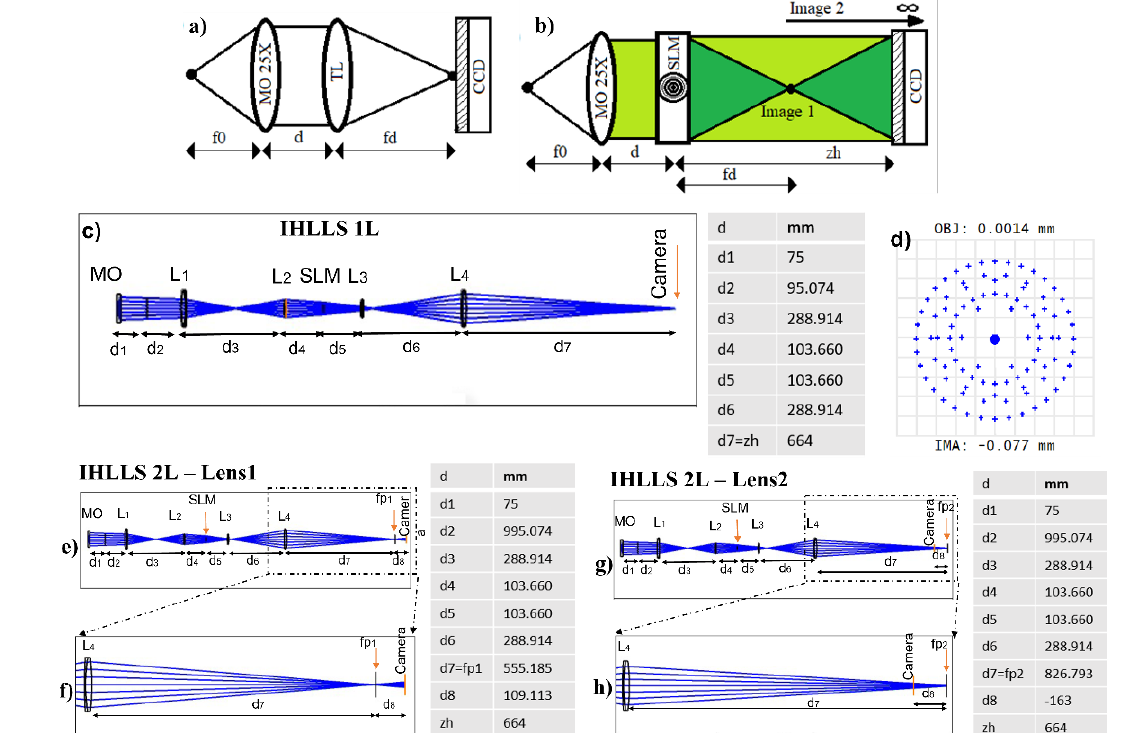
Figure 2. Optical setup terminology of LLS and IHLLS: ( a ) Schematic of the LLS detection path, MO: microscope objective of 25X with NA 1.1 and f 0 = 8 mm, TL: tube lens of focal length f d = 500 mm that focusses on the camera; ( b ) FINCH schematic with only one diffractive lens of focal length f d , and a phase constant (spherical wave with infinite radius) applied on the SLM, z h is the distance between the SLM and camera, z h = 2 f d for the best overlap of the two beams at camera; ( c ) Ray tracing using only one diffractive lens in IHLLS 1L, with a focal length of f SLM = 400 mm. The focal length was calculated using OpticStudio (Zemax, LLC), with the constraint used for the optimization process that the transversal magnification of the two systems, LLS and IHLLS-1L, should be the same: M T − IHLLS 1L = M T − LLS = 62.5; ( d ) The spot diagram from ( c ); ( e ) Ray tracing using two diffractive lenses, IHLLS 2L, of focal lengths f d1 = 220 mm and f d2 = 2356 mm, and f p1 being the first imaging position at 109 mm in front of the camera; ( f ) The inset shows that the first imaging position is placed in front of the camera; ( g ) Ray tracing using two diffractive lenses, IHLLS 2L, with f p2 being the second imaging position at 163 mm behind the camera; ( h ) The inset shows that the first imaging position is placed in front of the camera. The two focal distances, f d1 and f d2 , were obtained from a multi-configuration optical system with the condition that the height of the two beams was equal at the camera plane for a perfect overlap; distance d 1 is the distance between the MO and a dummy surface with infinite radius needed to check the beam collimation after the MO. Distance d 2 is the distance between the dummy surface and lens L 1 . Lenses L 1 = L 4 with focal lengths 175 mm and L 2 = L 3 with focal lengths 100 mm.